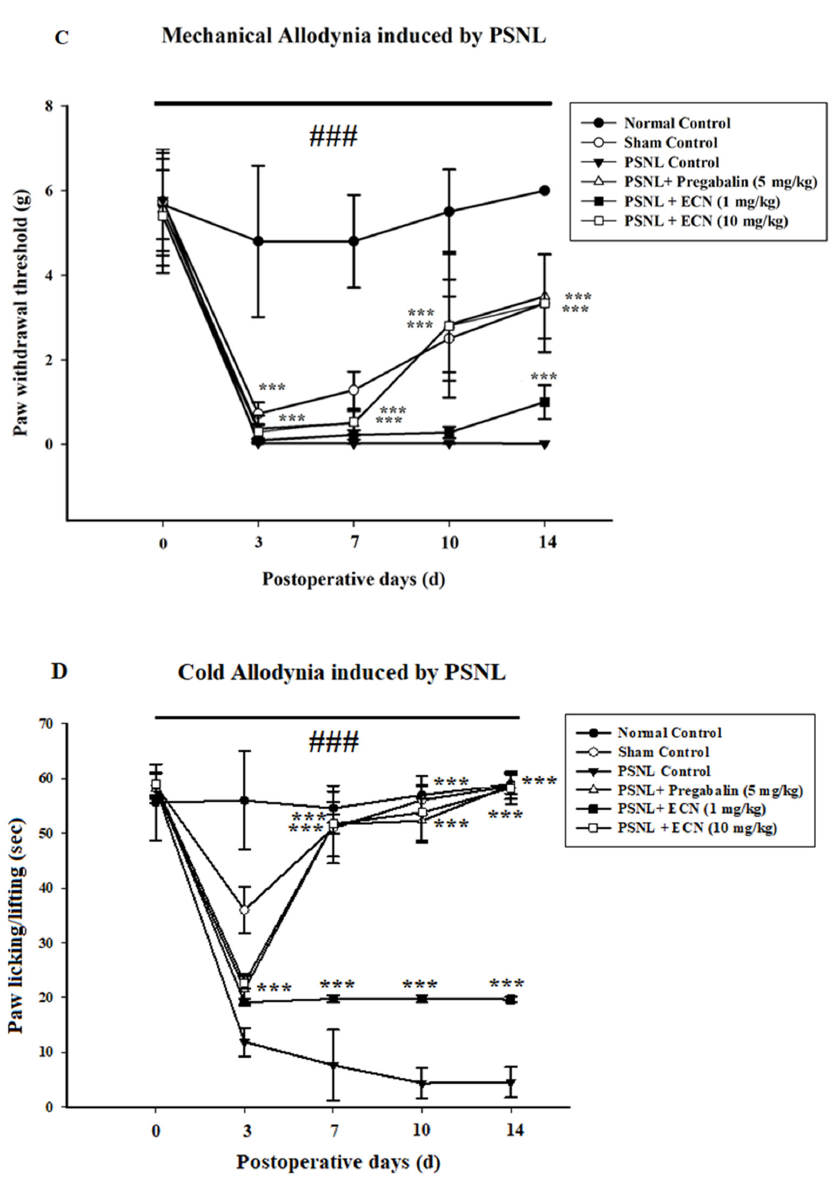
Figure 2. Effect of ECN treatment on mechanical hyperalgesia, thermal hyperalgesia, mechanical allodynia and cold allodynia. ( A ) Inhibition of PSNL-induced mechanical hyperalgesia at 0, 3, 7, 10 and 14-day intervals by ECN (1 and 10 mg/kg i.p.). ( B ) Inhibition of PSNL-induced thermal hyperalgesia at 0, 3, 7, 10 and 14-day intervals by ECN (1 and 10 mg/kg i.p). ( C ) Inhibition of PSNL-induced mechanical allodynia at 0, 3, 7, 10 and 14-day intervals by ECN (1 and 10 mg/kg i.p). ( D ) Inhibition of PSNL-induced cold allodynia at 0, 3, 7, 10 and 14-day intervals by ECN (1 and 10 mg/kg i.p). The data were reported as the means ± S.D. Different letters meant statistically significant differences: (***) p < 0.001 indicate significant differences from the PSNL control group. (###) indicate significant differences from the normal control group. *** p < 0.001 (two-way ANOVA followed by Dunnett’s test).